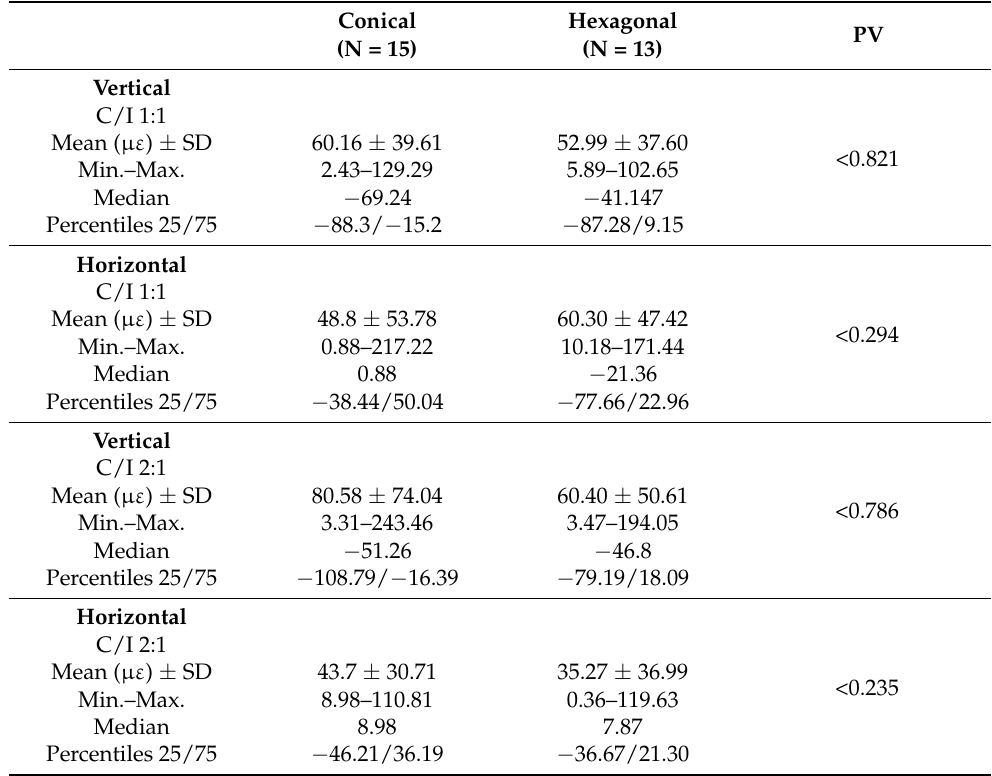
Table 4. Intragroup comparison of hexagonal and conical connection values of the STI when C/I tatio is 1:1 and 2:1. µε are related in both connections and C/I ratio at the same implant